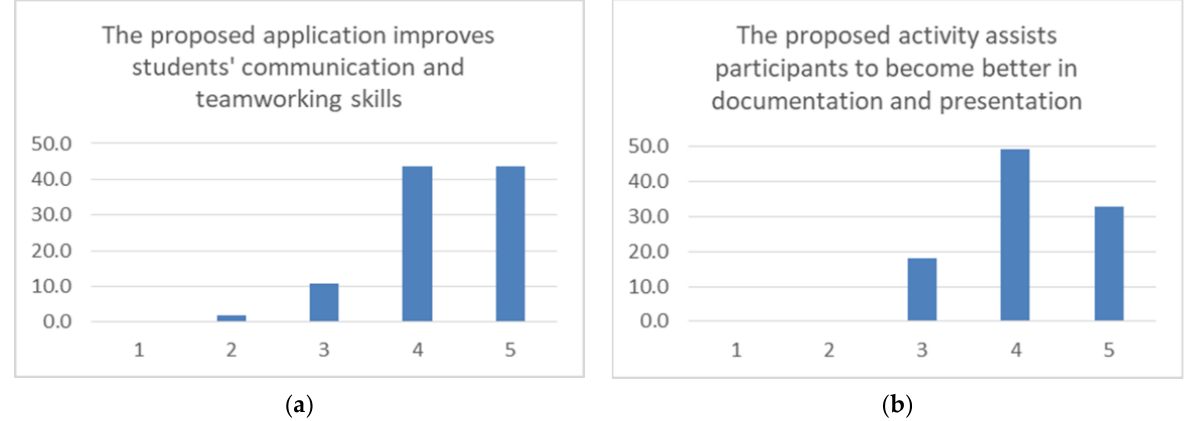
Figure 18. Opinion about the contribution of the proposed activity to improve: ( a ) the students ’ communication and teamworking skills; ( b ) the students ’ ability to document and present their work.